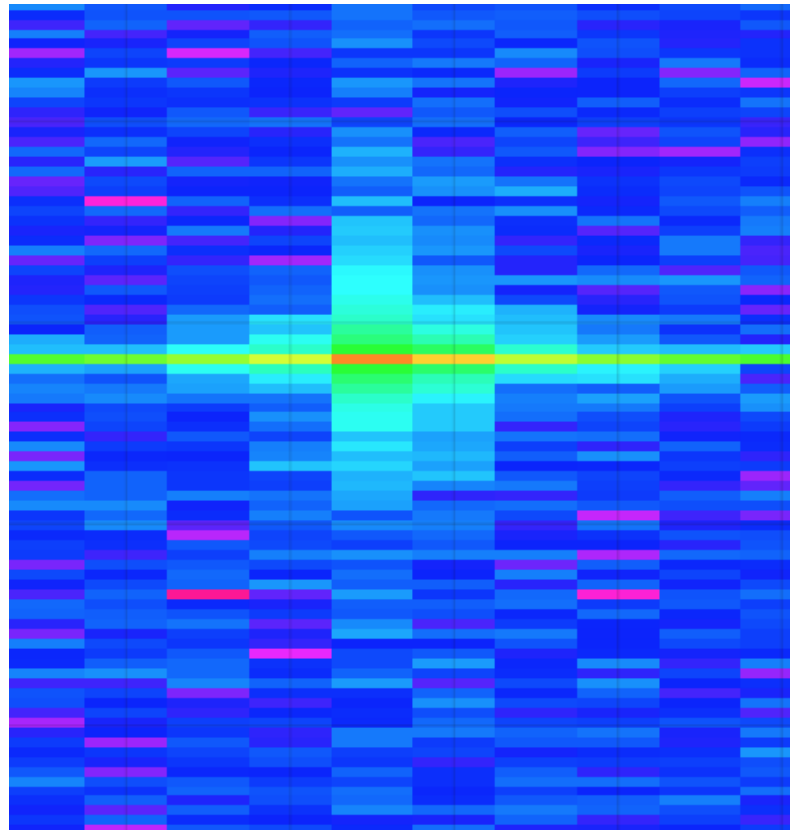
Figure 5. Generated radar range-Doppler heatmap